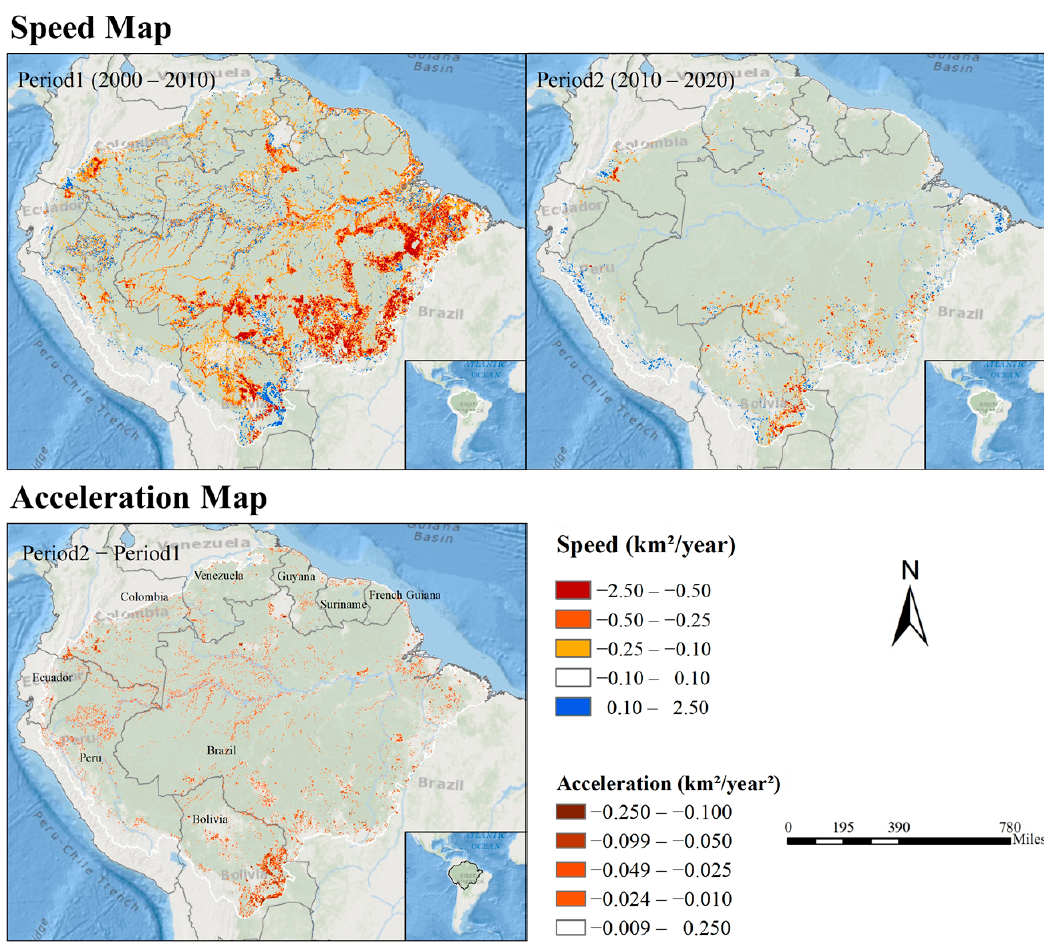
Figure 8. The speed and acceleration maps of forest loss in the Amazon basin. The negative value in the speed legend represents the speed of forest loss, and the negative value of acceleration represents the acceleration of forest loss.